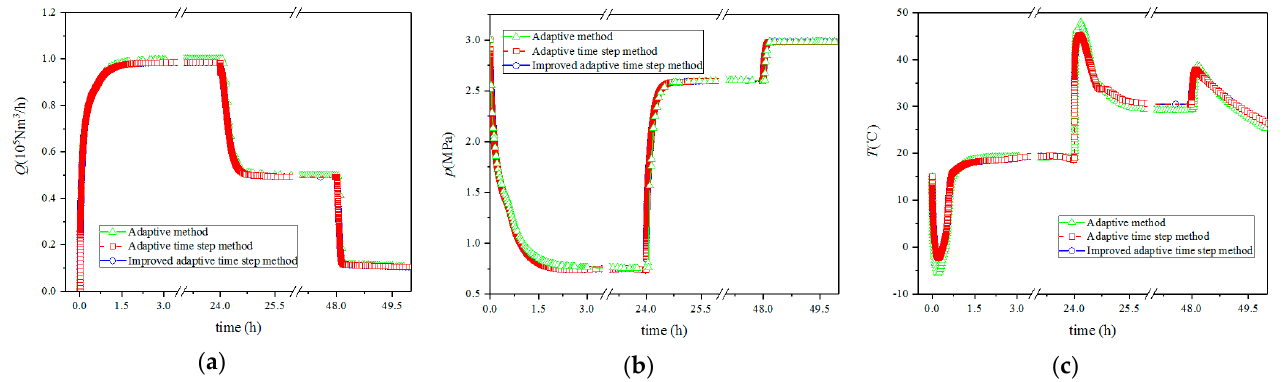
Figure 3. The result of the simulation. ( a ) The flow rate at the inlet; ( b ) The pressure at the outlet; ( c ) The temperature at the outlet.